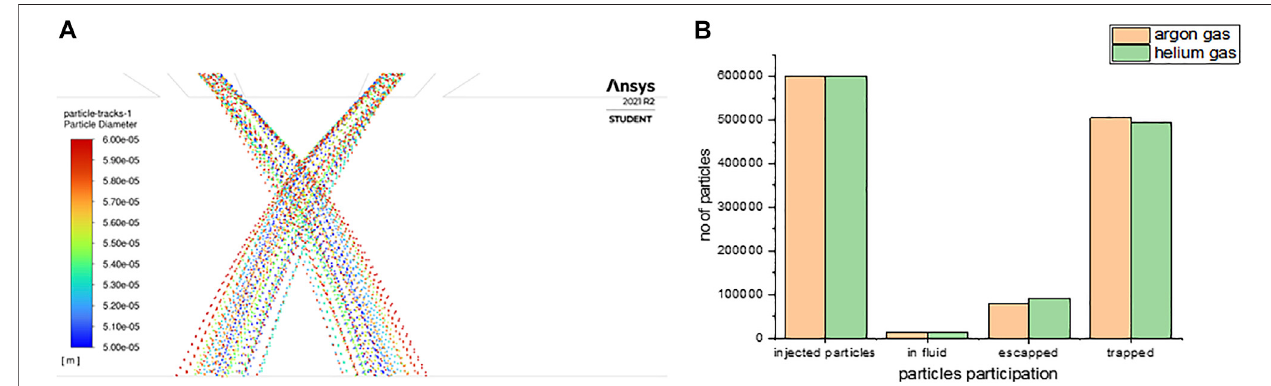
FIGURE 14 | Simulated results of particle convergence particle participation for 60 – 70 µm size.